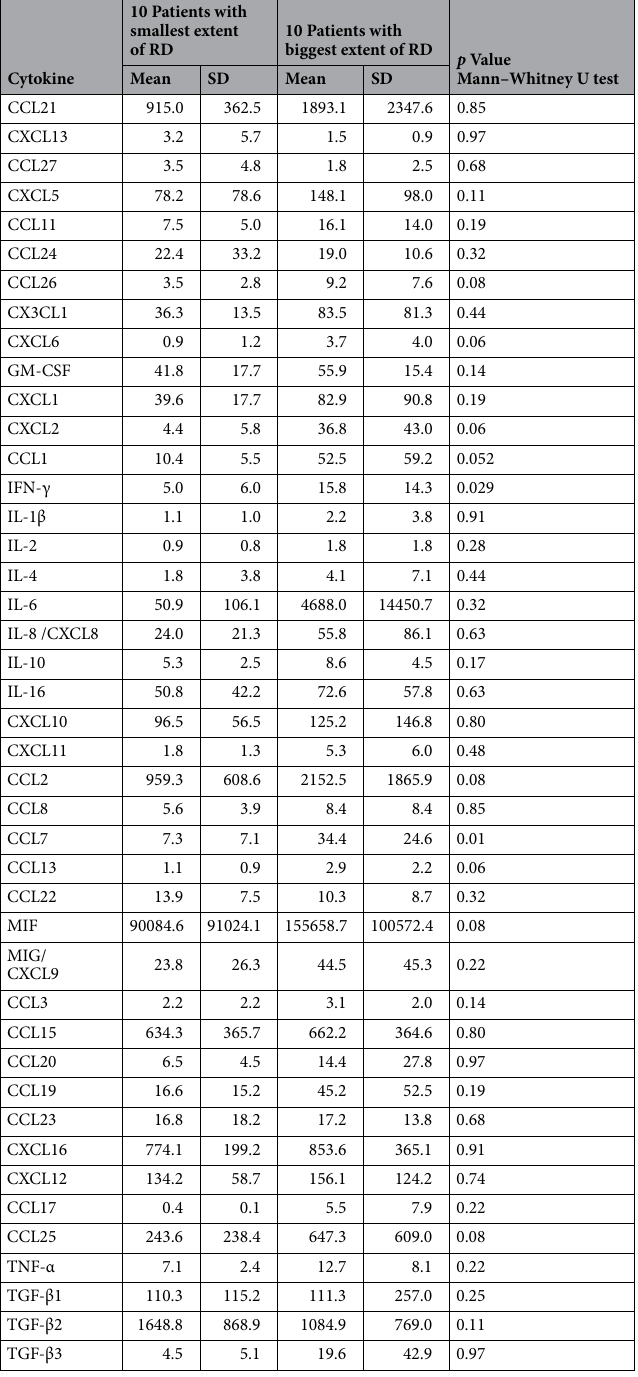
Table 3. Comparison of the vitreal cytokine concentrations between the 10 patients with the smallest vs. biggest extent of retinal detachment (RD). After Holm correction, none of the p values remain